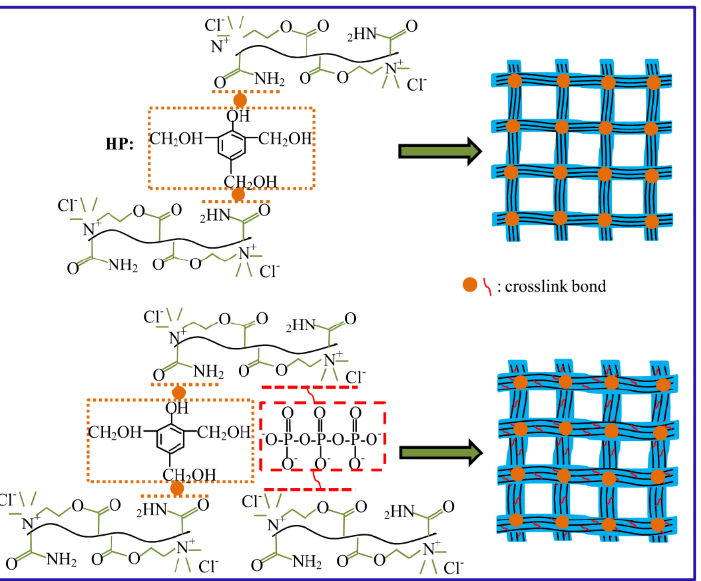
Figure 8. Crosslinking principles of the polymer gel with and without the addition of STPP crosslinker, respectively (Reprinted/adapted with permission from Ref. [59]. 2015, Chen, et al”) .